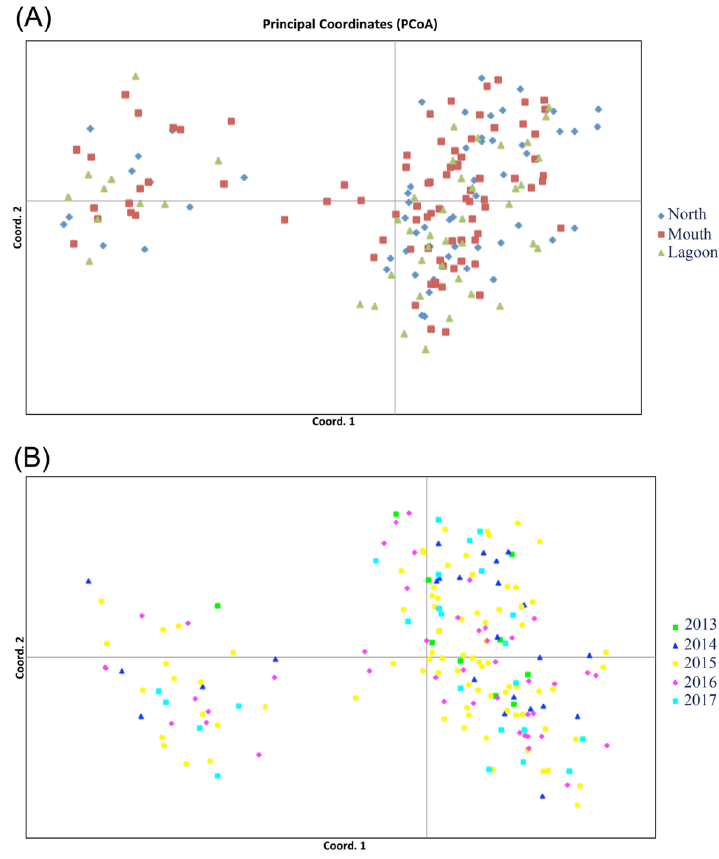
Figure 3. Principal coordinate analysis (PCoA) on individual microsatellite genotypes. A) PCoA based on 9 microsatellite loci from 188 juveniles assigned to 3 locations. B) PCoA based on 188 juveniles assigned to 5 cohorts. Each symbol represents a unique individual with symbol color and shape denoting different assignment